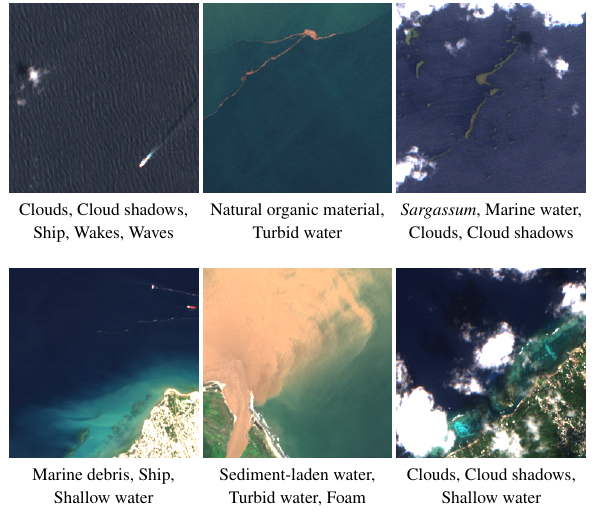
Figure 1. Example of S2 patches provided in MARIDA (Kikaki et al.,